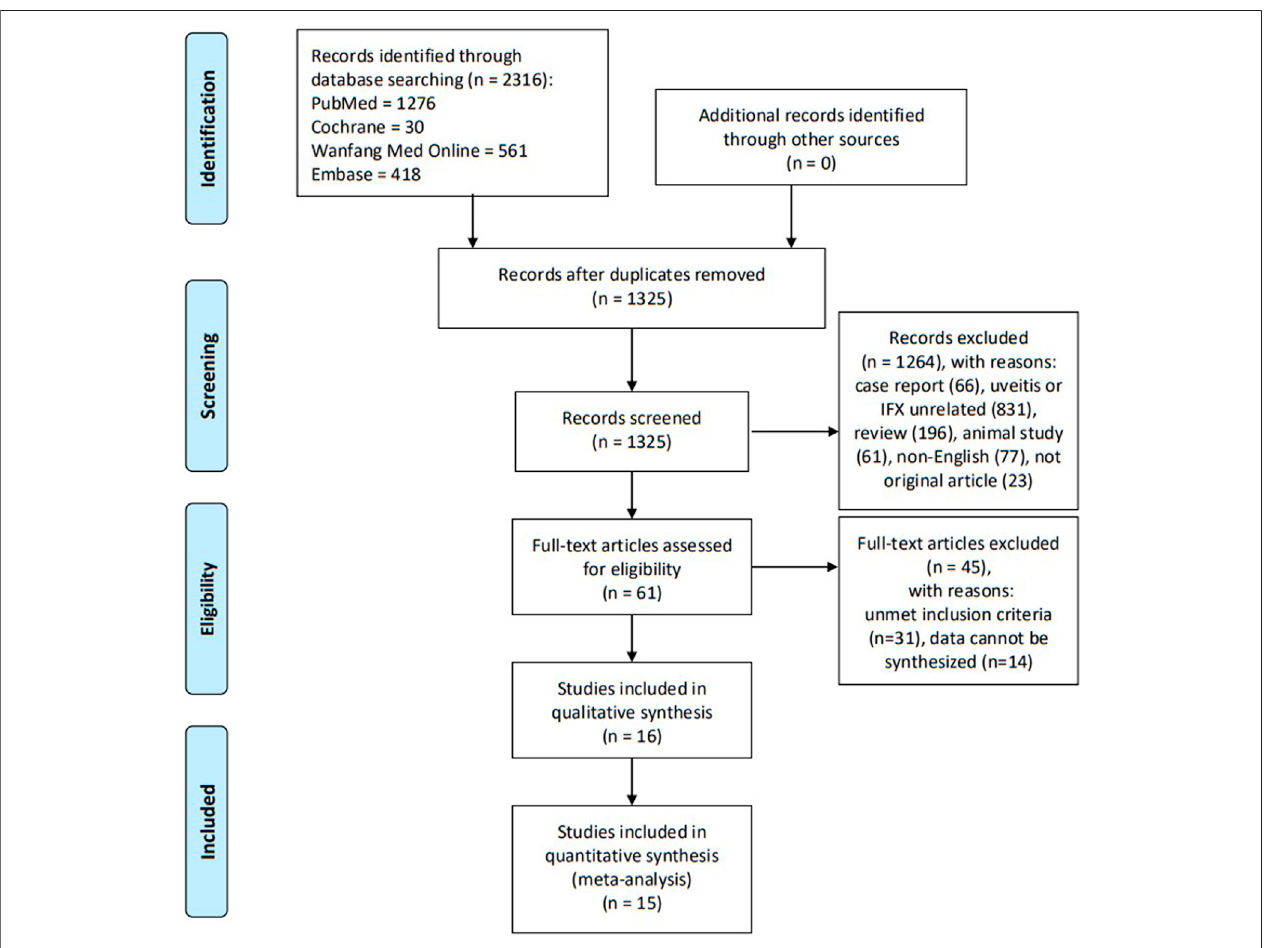
FIGURE 1 | Flowchart demonstrating the process of study